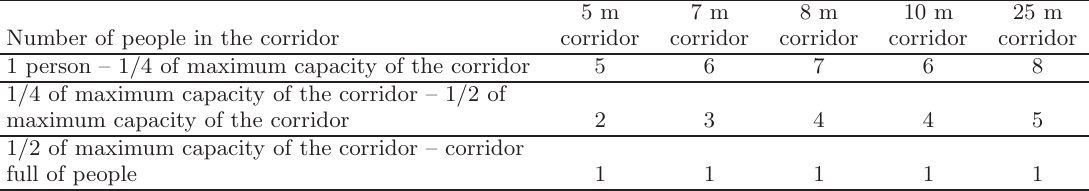
Table 2. Evacuation speed (m/s) as a function of the number of people in a corridor and its length.